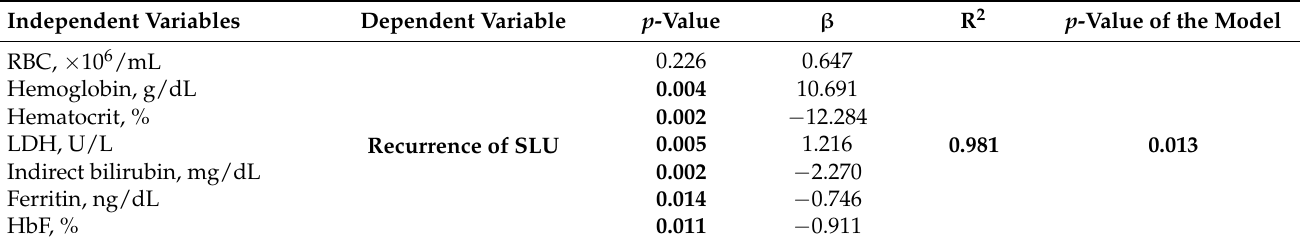
Table 5. Linear regression multivariate model of SLU recurrence in aassociation with labora- tory biomarkers.